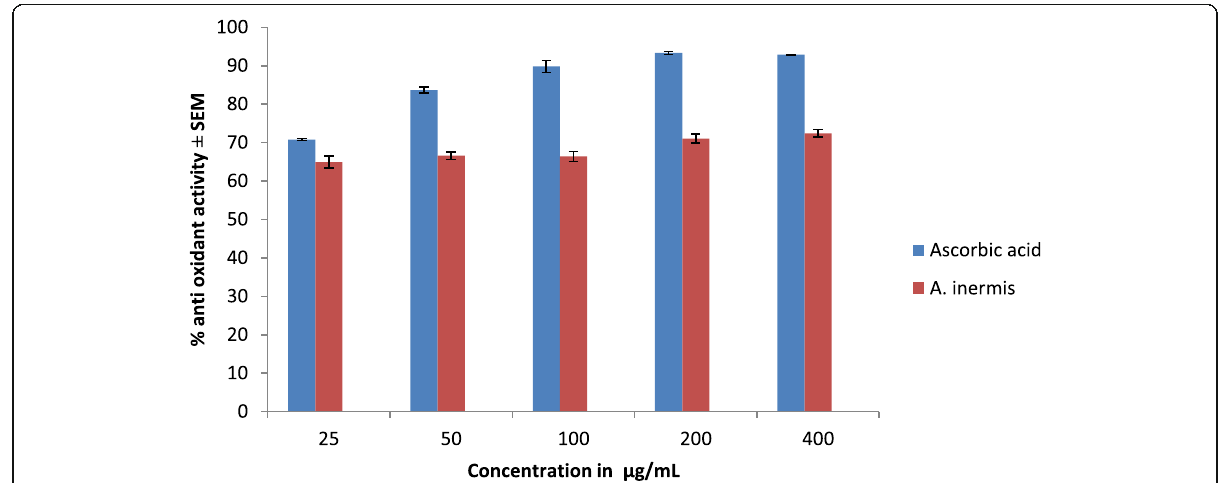
Fig. 2 DPPH Test showing A.inermis percentage antioxidant activity (red bars) with Ascorbic acid as standard comparison (blue bars)